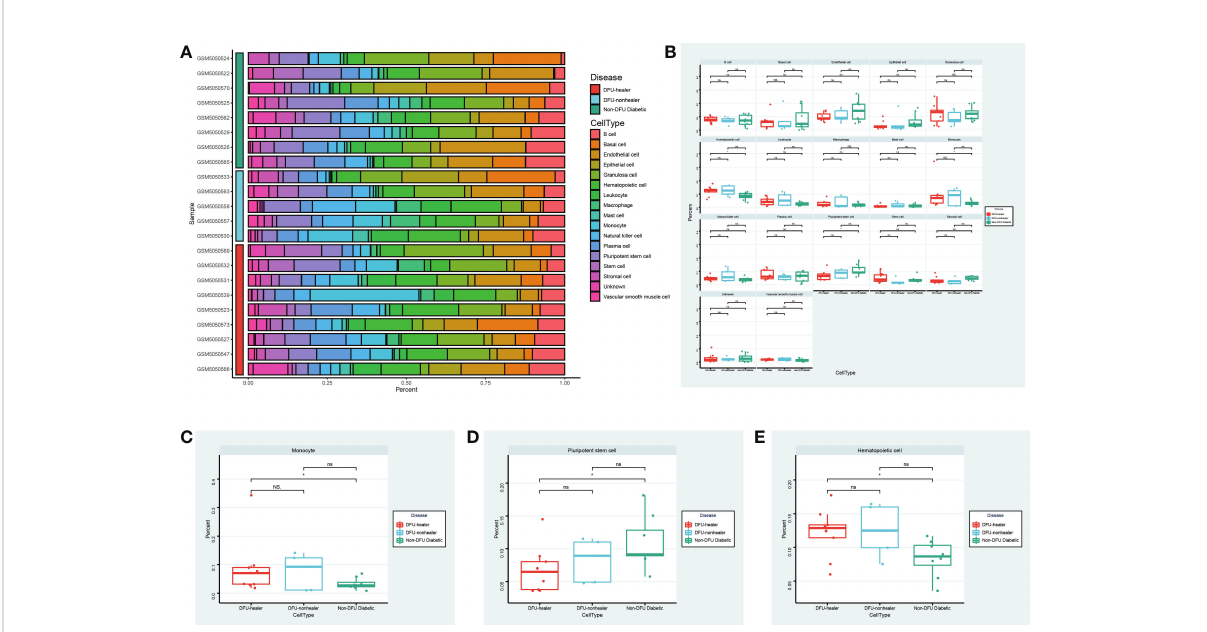
FIGURE 5 Speci fi c cell abundance in different samples. (A) The heatmap shows the annotated cell abundance within different disease samples. (B) The box plots compare the differences in the percentage of each cell type between the different groups. Specially, (C, D, E) show respectively